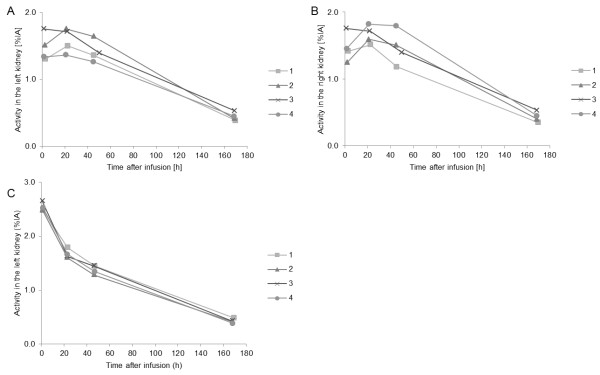
The177Lu activity in the right and left kidneys given as percent of injected activity. The 177Lu activity in the right and left kidneys given as percent of injected activity (%IA) for (A) and (B) patient no. 8 (left and right kidneys, treatment cycles 1 to 4) and (C) for patient no. 24 (left kidney, treatment cycles 1 to 4).